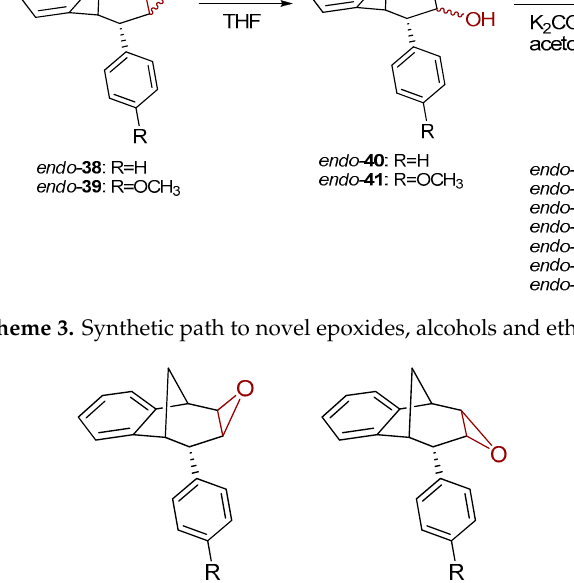
Figure 5. Representation of the stereoisomers of the obtained epoxides endo - 38 (R = H) and endo - 39 (R = OCH 3 ).